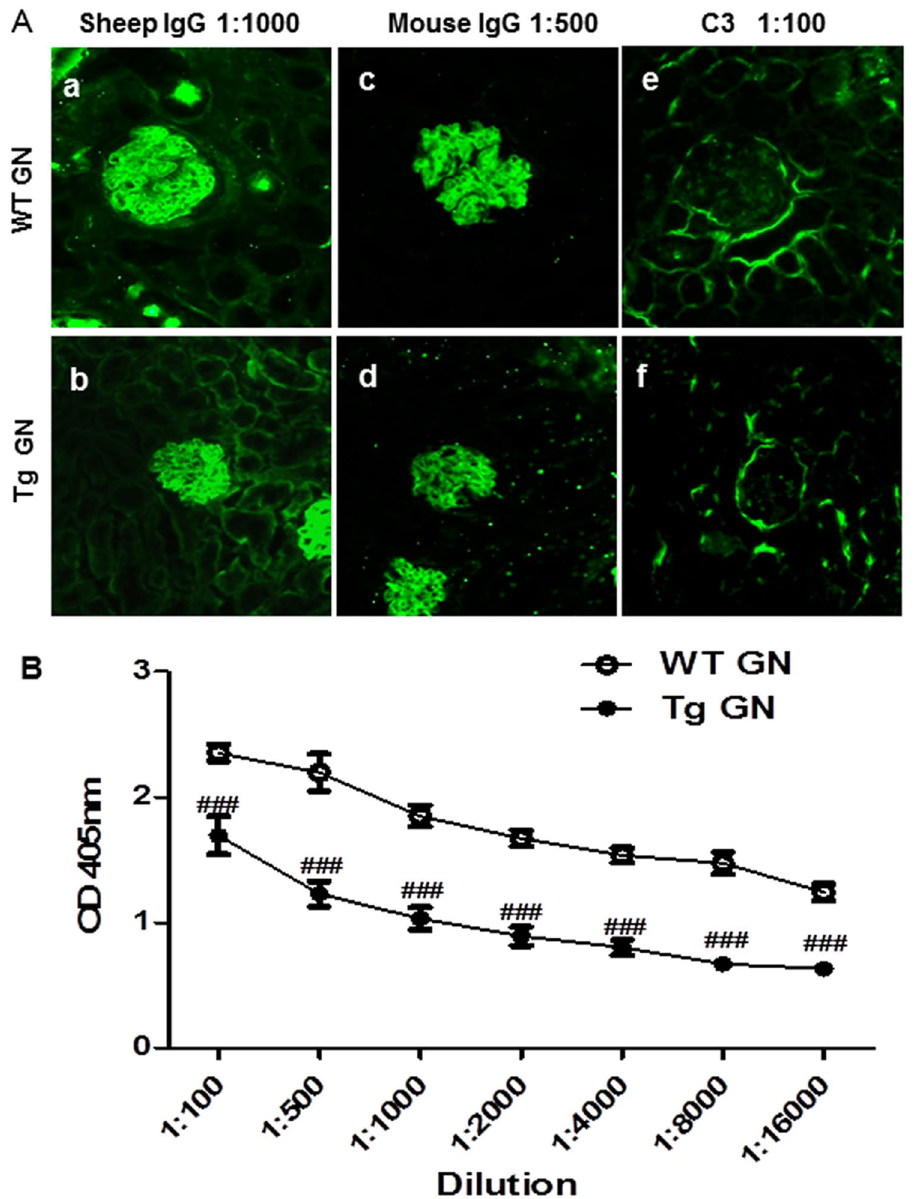
Figure 9. Overexpression of Foxp3 attenuates plasma mouse anti-sheep IgG antibody production but does not affect immune complex deposition in inflamed glomeruli. ( A ) Representative immunofluorescence staining of glomeruli from WT and Tg mice with anti-GBM GN for the deposition of sheep IgG ( a and b ), mouse IgG ( c and d ) and mouse C3 ( e and f ). ( B ) ELISA test of plasma mouse anti-sheep IgG from WT and Tg mice with anti- GBM GN. Each bar represents mean ± SEM. ### p < 0.001 compared with the WT mice. n = 6–8 mice per